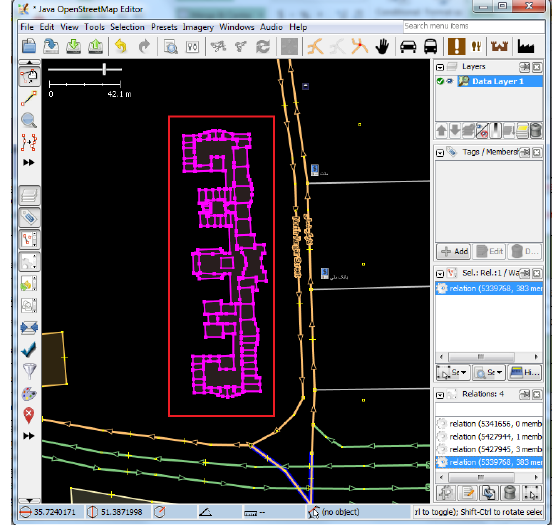
Figure 3. Footprint of case study building in JOSM